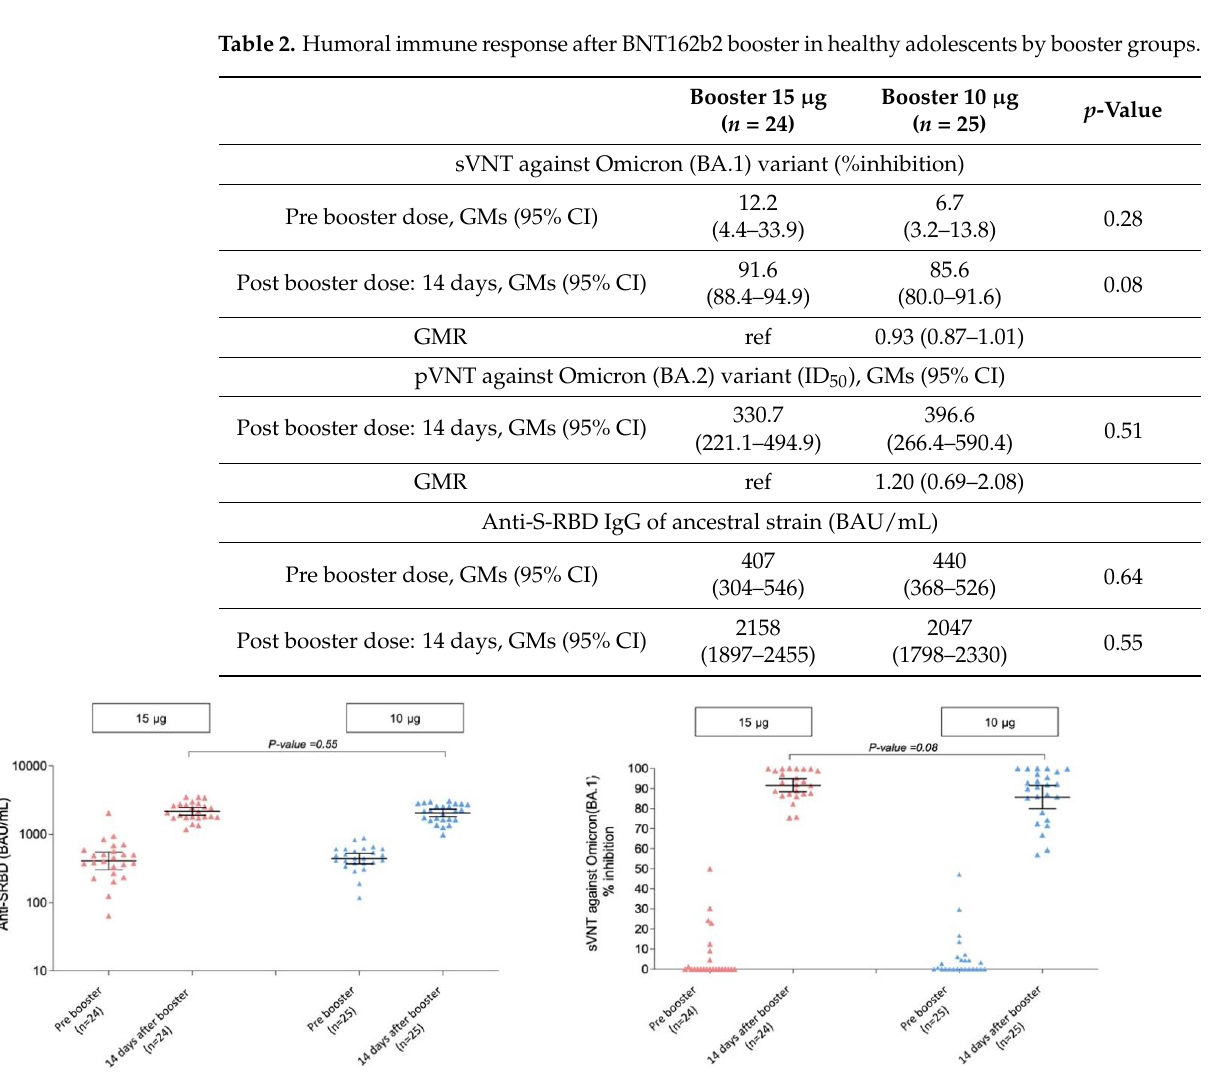
Figure 4. Humoral immune response after BNT162b2 booster in healthy adolescents by booster groups: ( A ) Anti-S-RBD IgG of ancestral strain (BAU/mL) ( B ) sVNT against Omicron variant (%in- hibition).